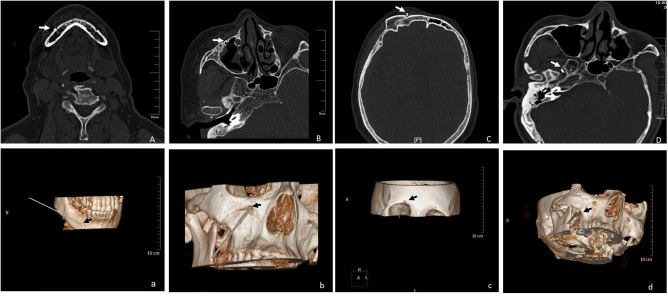
(A-a) CT scan and 3D-CT showed the path and position of the needle located in the right mental nerve, shown by the arrow; (B-b) CT scan and 3D-CT showed the path and position of the needle located in the right infraorbital nerve, shown by the arrow; (C-c) CT scan and 3D-CT showed the path and position of the needle located in the right supraorbital nerve, shown by the arrow; (D-d) CT scan and 3D-CT showed the path and position of the needle located in the right foramen ovale, shown by the arrow.